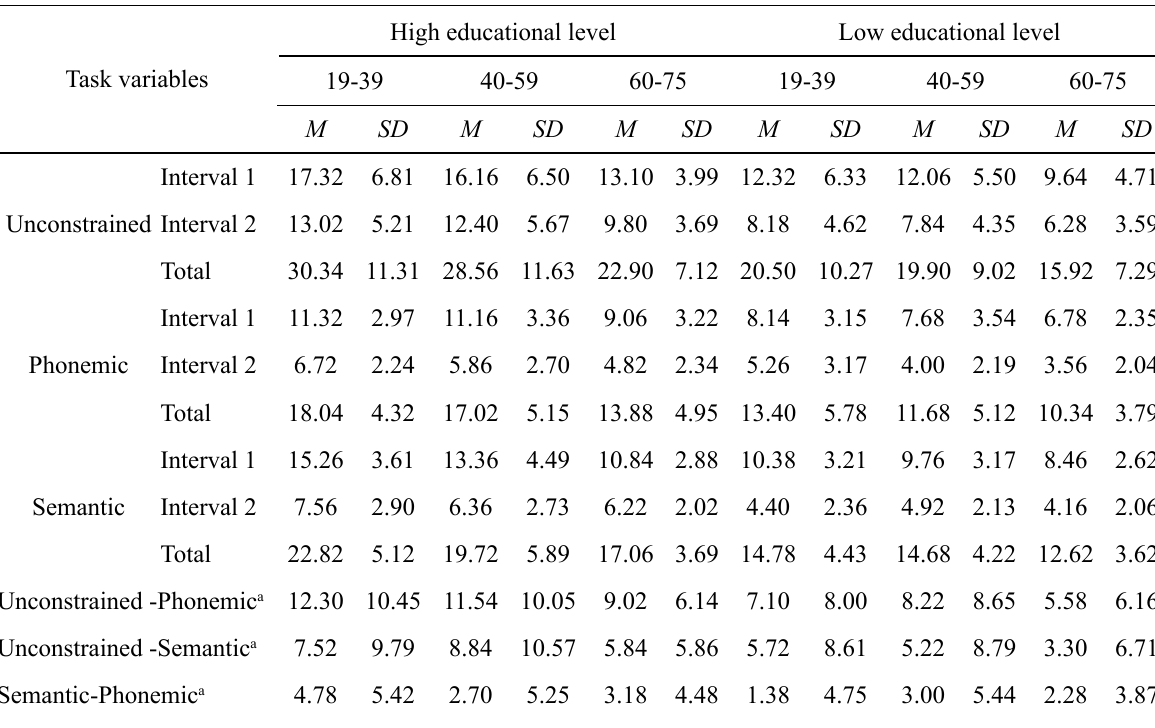
Normative Data on Performance and Discrepancy score According to Age and Educational Level